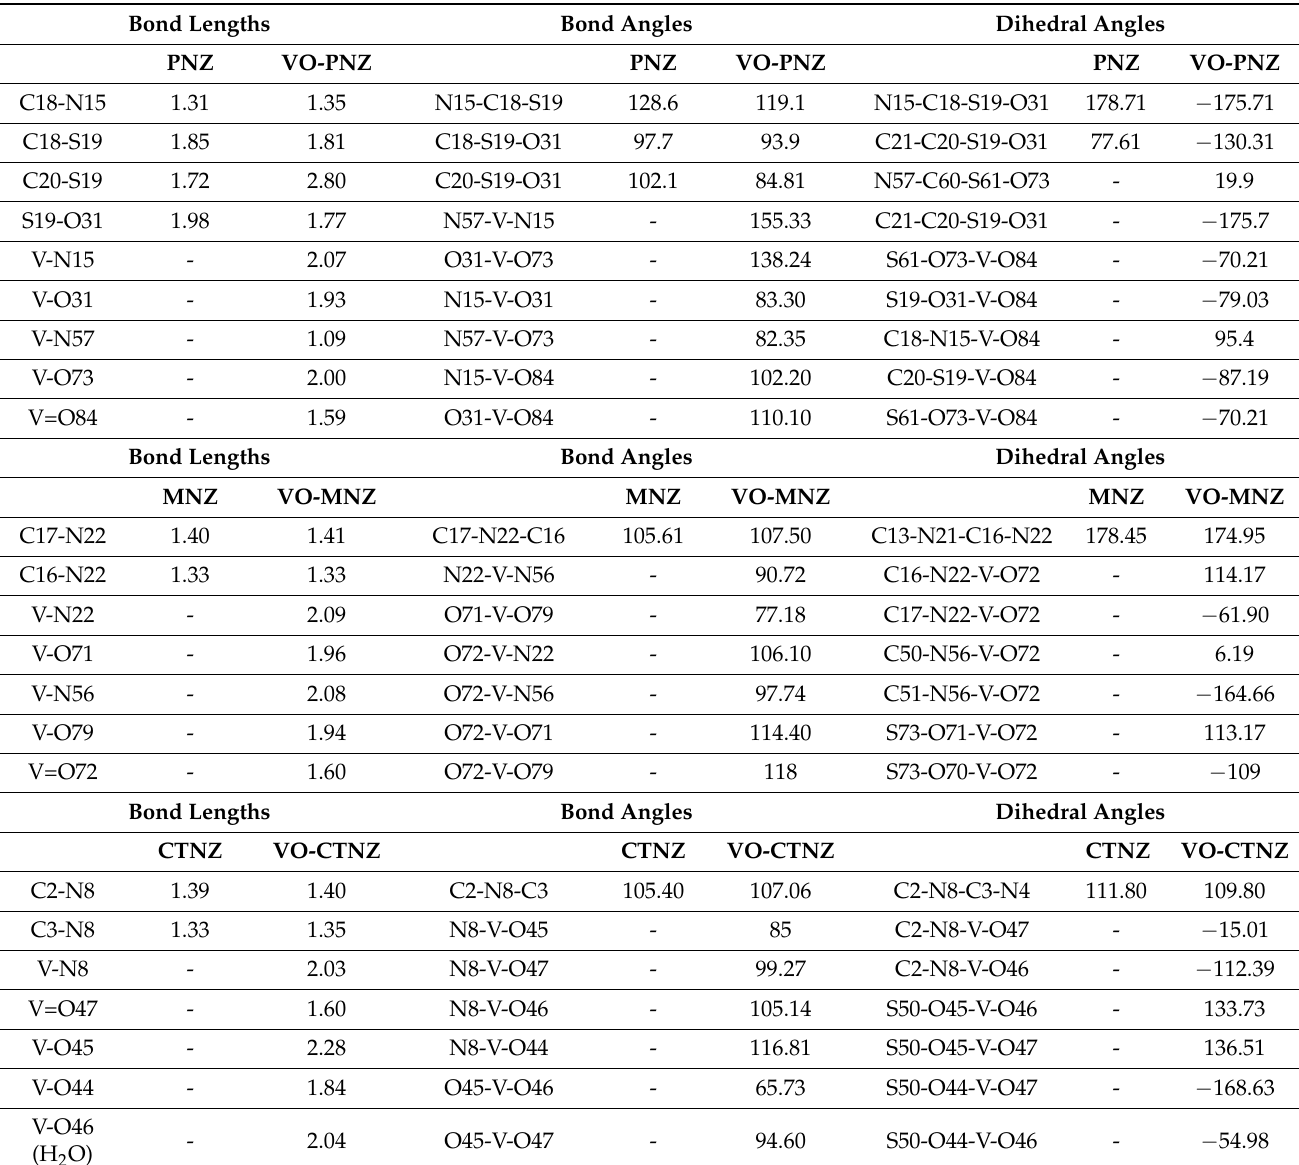
Table 2. Selected geometric bond lengths, bond angles, and dihedral angles of the optimized ligand and oxidovanadium(IV)